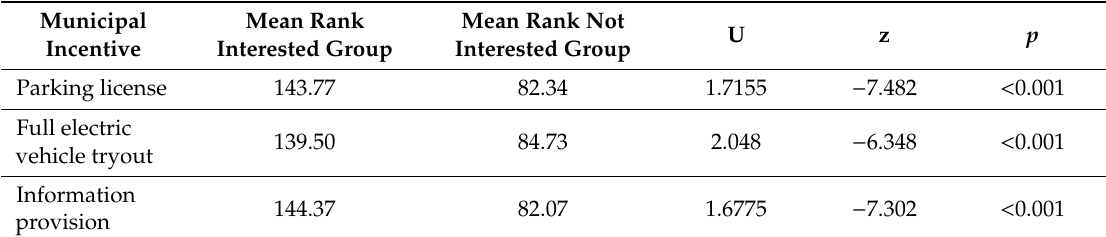
Table 4. Results of Mann–Whitney U tests on the rated attractiveness of the municipal